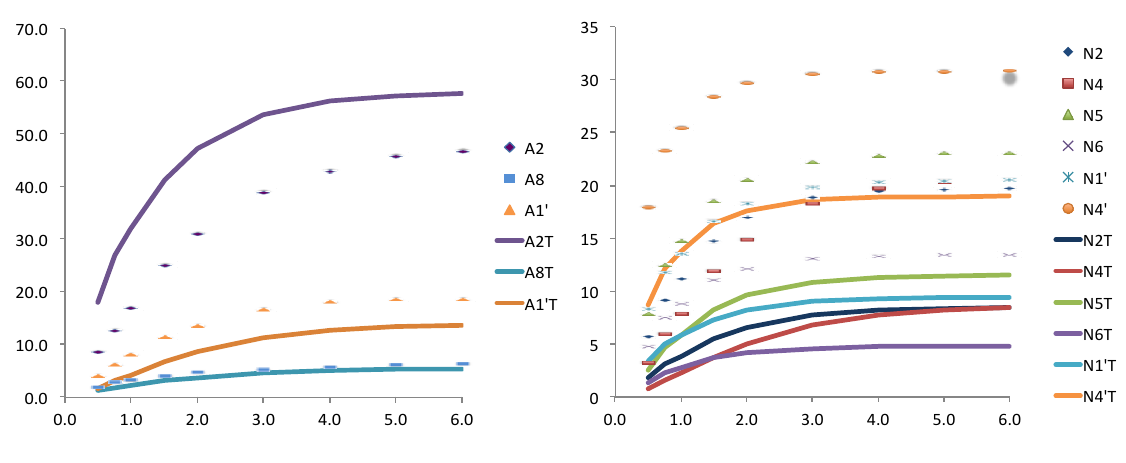
Figure 4. Relative STD experimental (dots) and theoretically predicted (lines) with CORCEMA for one structure taken from MD simulation and further minimized, for the adenosine (left) and for the nicotinamide (right)